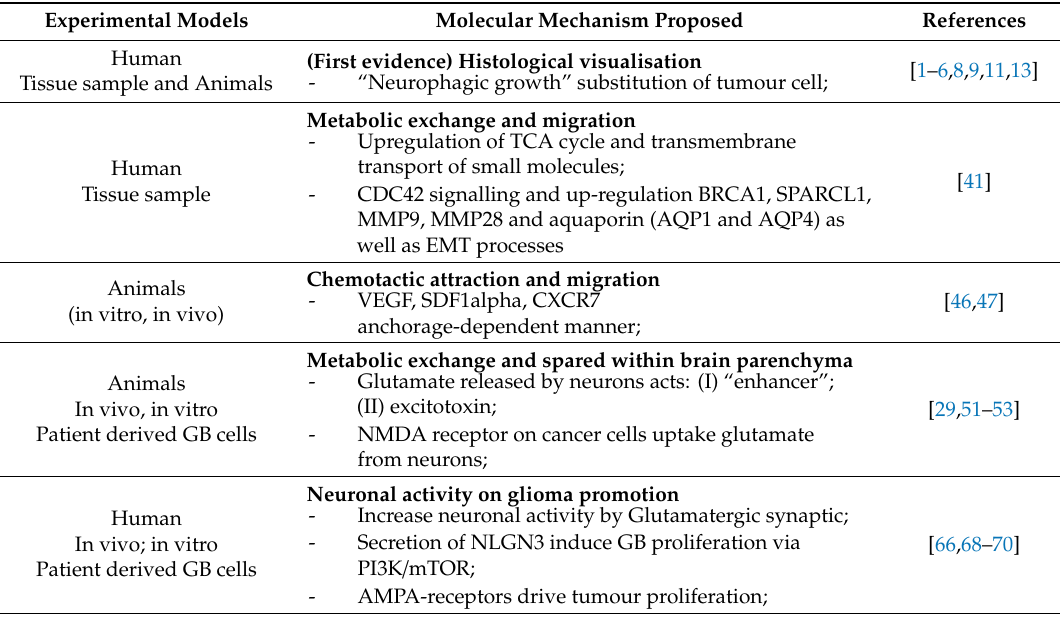
Table 1. Summary of studies investigating the Perineuronal Satellitosis process within brain tumour in in vivo and in vitro models along with the molecular mechanism proposed. Bold: is a summary title which encompass di ff erent